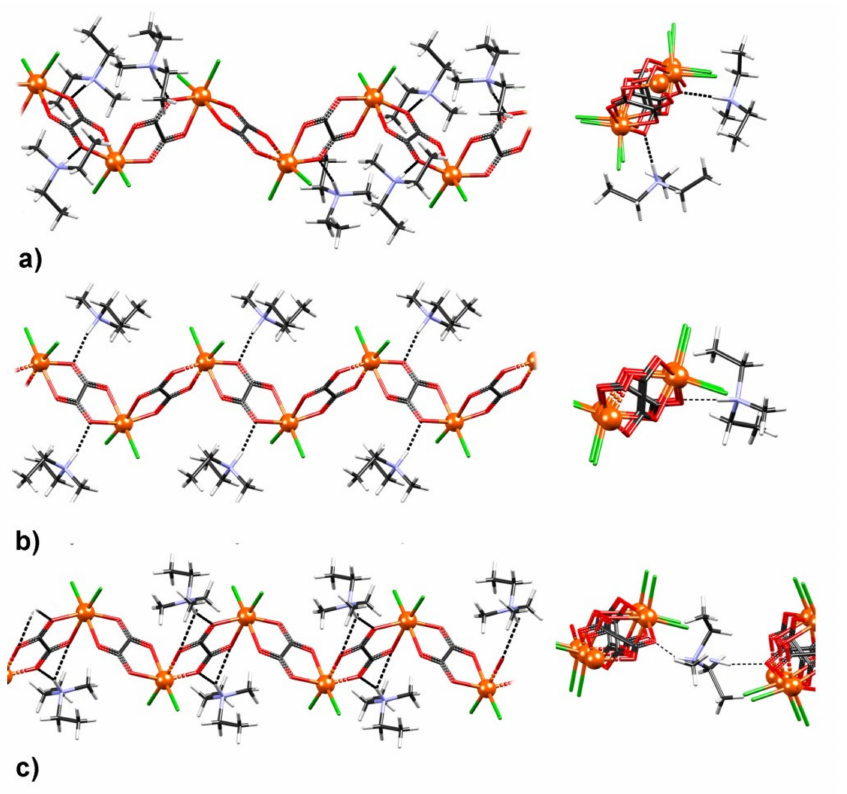
Figure 4. The [FeCl 2 (C 2 O 4 )] nn − chains with hydrogen-bonded cations in ( a ) LT-1 , ( b ) MT-1 , and